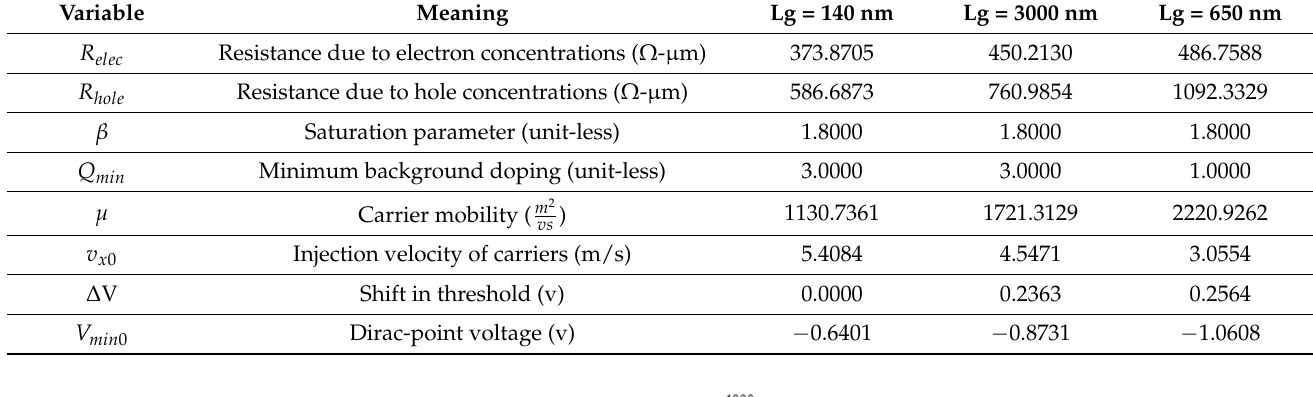
Table 2. Parameters in the AVS v1.0.0 model that are extracted upon calibration with NEGF data.